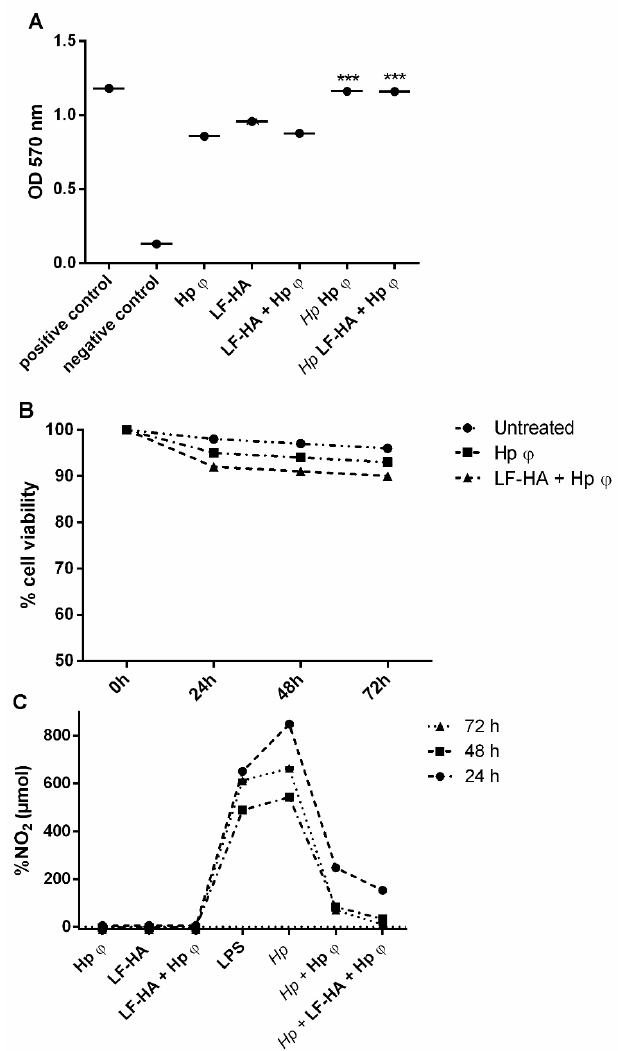
Figure 3. Cytotoxic assays. ( A ) MTT assay for cell viability. The experiment was performed in untreated AGS cells; cells treated with 50% ethanol; phage alone; Hp and phage; Hp and the complex Hp φ + LF-HA . ( B ) Trypan blue test was performed at 72 h of treatment with 24 h time point. ( C ) % of NO 2 levels in the culture medium. The measurements, obtained by Griess assay, were carried out in: Untreated AGS cells; cells treated with LPS (10 µg/mL); cells treated with Hp ; cells treated with phage alone or combined with LF-HA; cells treated with Hp and phage alone or combined with LF-HA. *** p < 0.001. Statistical analysis was performed with Student’s t-test. Values are the mean ± SD from three independent experiments with three replicates for each data point. 3.4. In vitro infection of AGS cells with Helicobacter pylori and treatment with Hp φ +LF-HA AGS human gastric cells were infected with Hp and incubated simultaneously with the phage; or treated for 24 h with the bacteria and then incubated for 3 h with Hp φ alone or combined with